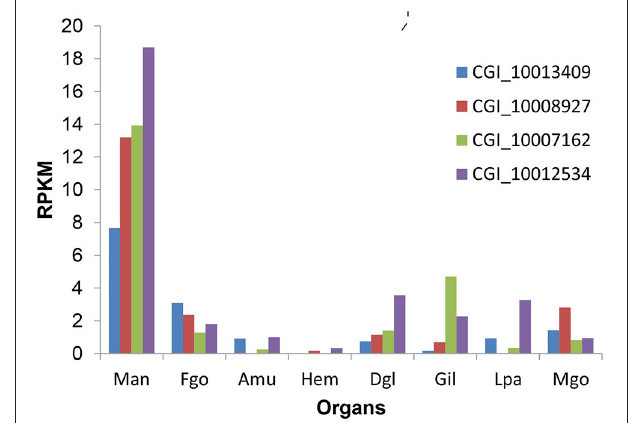
FIGURE 2 | The expression pattern of the four rhodopsin-like superfamily genes . Y-axis denotes expression as an RPKM value and the X-axis indicated different organs. The organs are abbreviated as follows: Man, mantle; Fgo, female gonad; Amu, adductor muscle; Hem, haemocyte; Dgl, digestive gland; Gil, gill; Lpa, labial palp; and Mgo, male